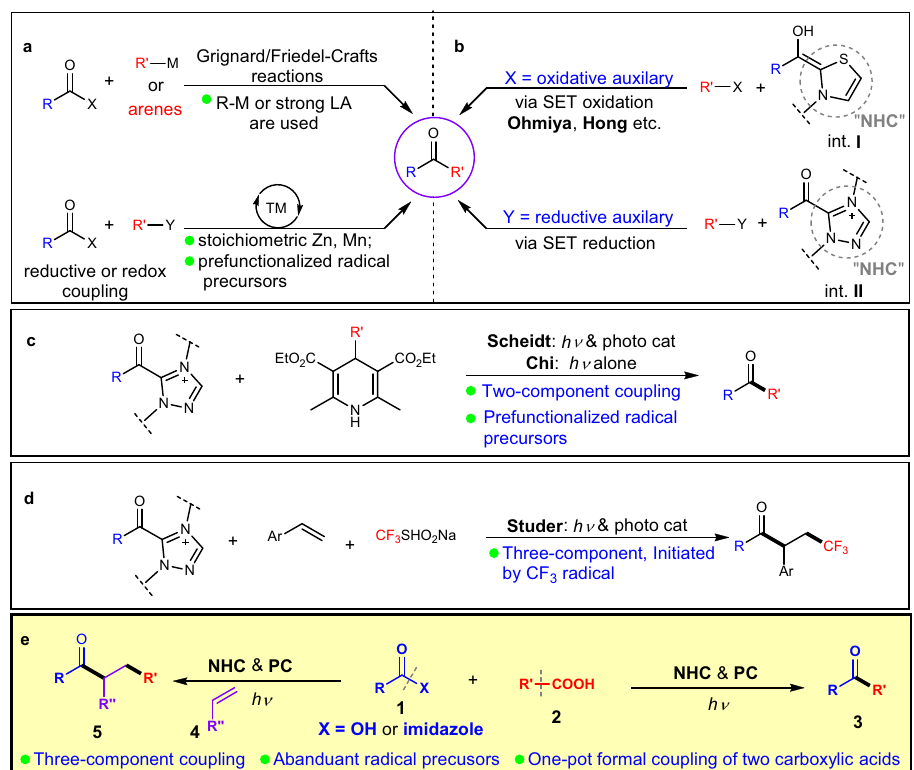
derived radical intermediates are typically persistent radicals, and